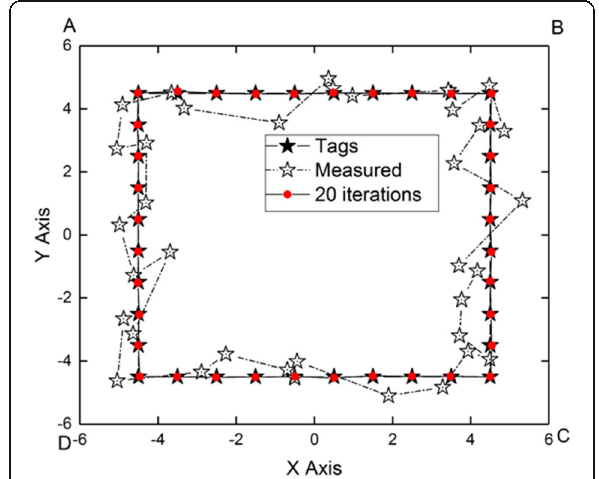
Fig. 11 Results of 20 iterations for 2D indoor localization. We illustrate the optimized position for each target after 20 iterations, which is denoted by the red dots. It can be find that the locations are approaching optimal; the ELPSO algorithm converges